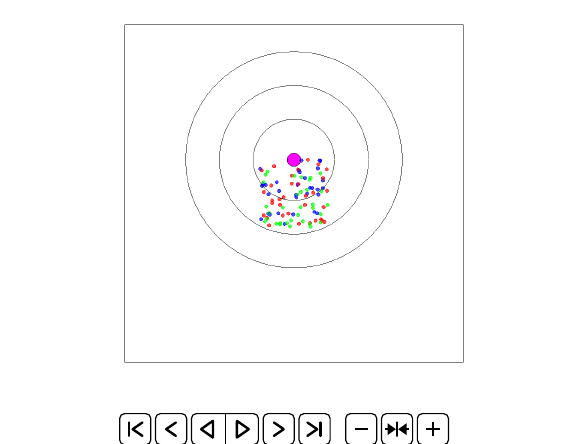
Figure 10. Video of the game when the blood vessel has a high probability of 0.01 per generation of dying and re-merging elsewhere. Even though the zone widths are large (5 units each), extinction always occurs within 5000 generations when neighborless cells cannot proliferate: σ = 0. This simulation pauses upon extinction.